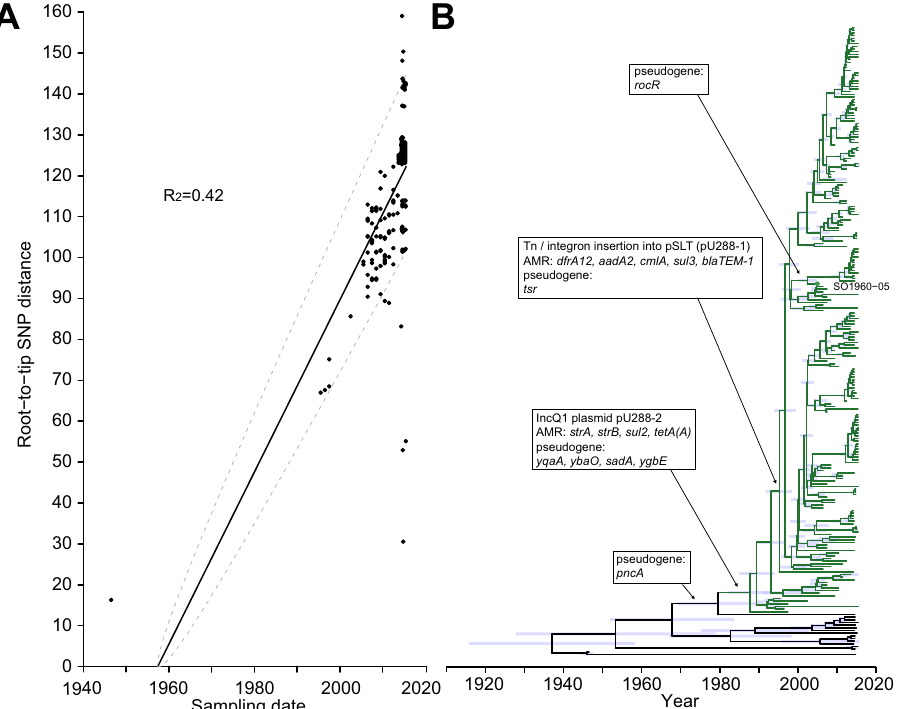
Fig. 5 Time-scaled phylogenetic analysis of the emergence of the U288 epidemic clade. Analysis of 234 U288 clade and closely related strains isolated between 1947 and 2015 calculated using maximum likelihood estimation based on recombination-purged variation in the core genome sequence. ( A ) Linear regression of root-to-tip SNPs with a slope of 2.05 SNPs per year, and ( B ) estimated time-scaled phylogeny, manually rooted using monophasic S . Typhimurium ST34 strain S04698-09 as an outgroup that was subsequently removed before further analysis. Blue bars at nodes indicate 95% CI of dated nodes, green lineages indicate the U288 epidemic clade, and black lineages indicate lineages closely related to the U288 clade. Major evolutionary events (arrows) of the acquisition of plasmids and AMR genes, and the accumulation of hypothetically disrupted coding sequences (HDCSs) resulting in possible pseudogene formation are indicated in